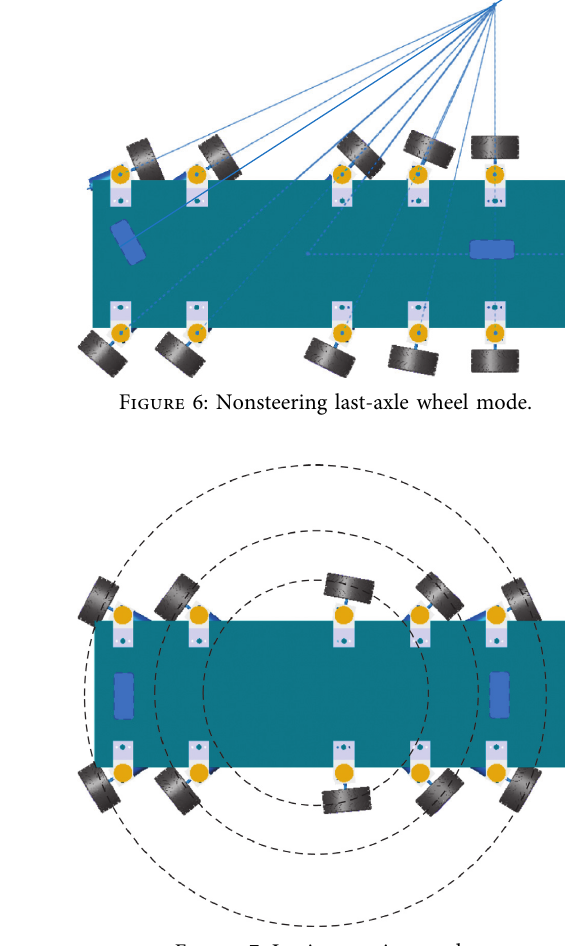
Figure 5: Nonsteering first-axle wheel mode.